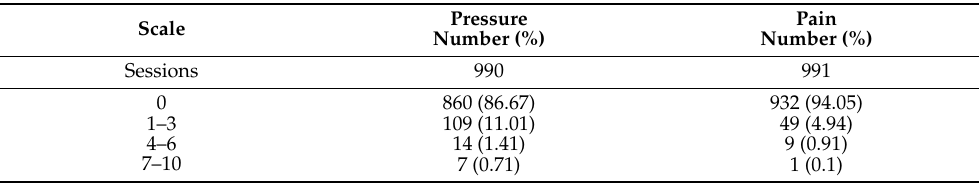
Table 1. Reported severity of pressure or pain sensation during TPS treatment. Scale on a range from 0–10. Data was taken from the TPS Therapy and Development Center in Vienna, Austria. Multiple scale occurrence was